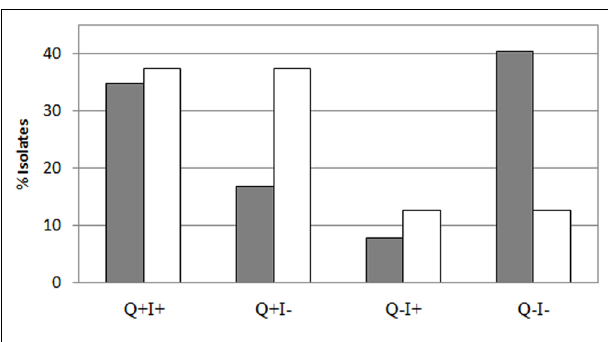
FIGURE 6 | Correlation between qnr and intl-1 presence: isolates exhibited a negative correlation between qnr (Q) and their intl-1 (I) content in sludge (white bars) and raw sewage (gray